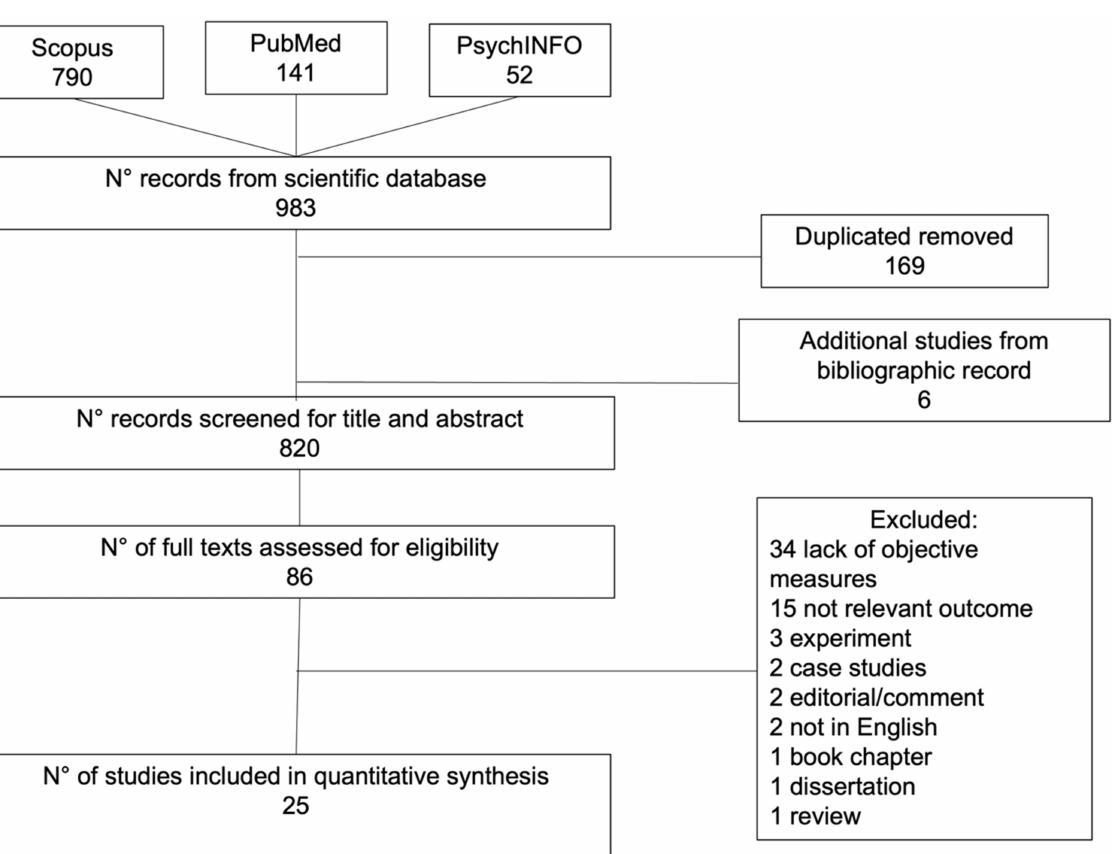
Figure 1. Flowchart for selection process of